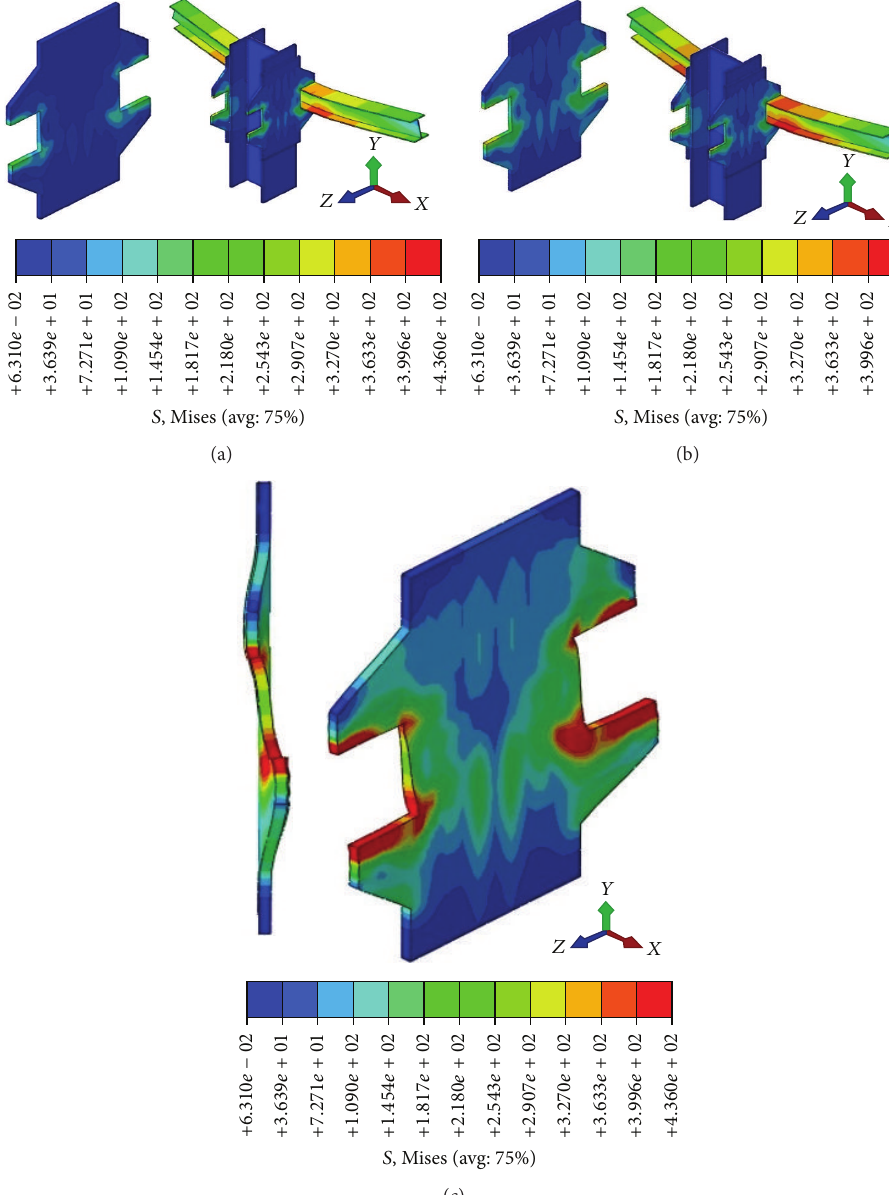
Figure 13: Saddlebag connection behaviour at the end of progressive collapse